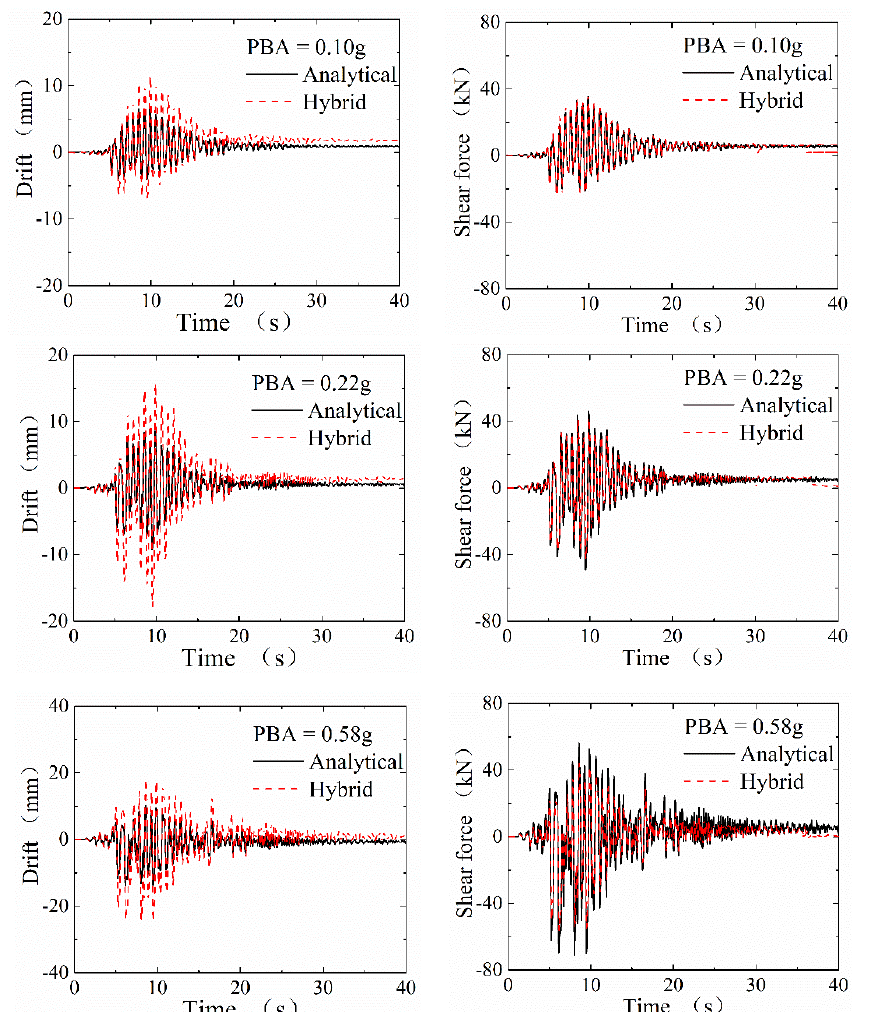
Figure 9. Test results of 0.1 g, 0.22 g, and 0.58 g case. PBA, peak base acceleration.